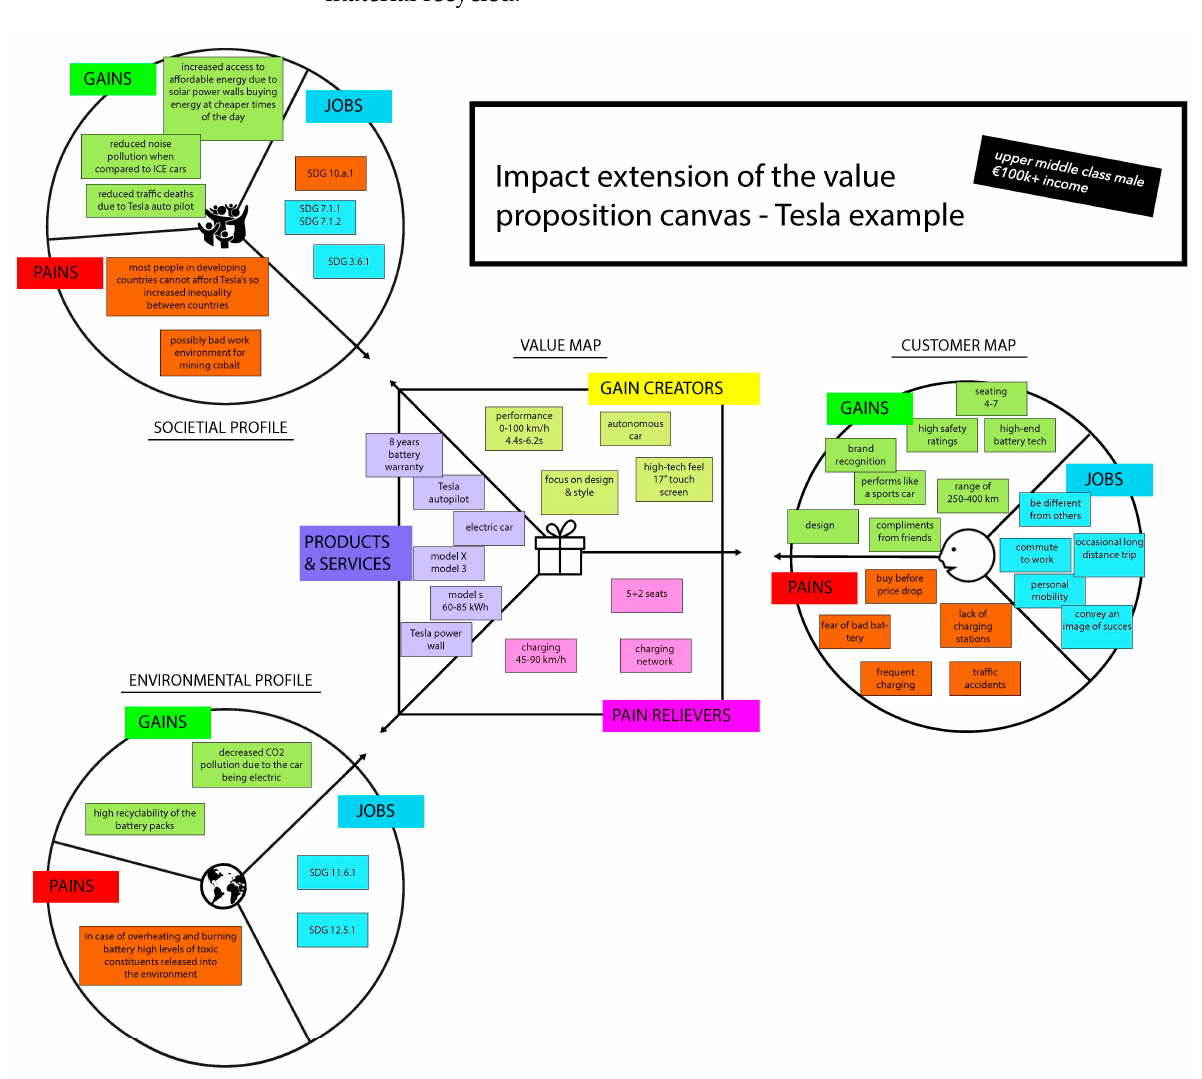
Figure 3. Example of societal and environmental profiles (as extension of VPC).